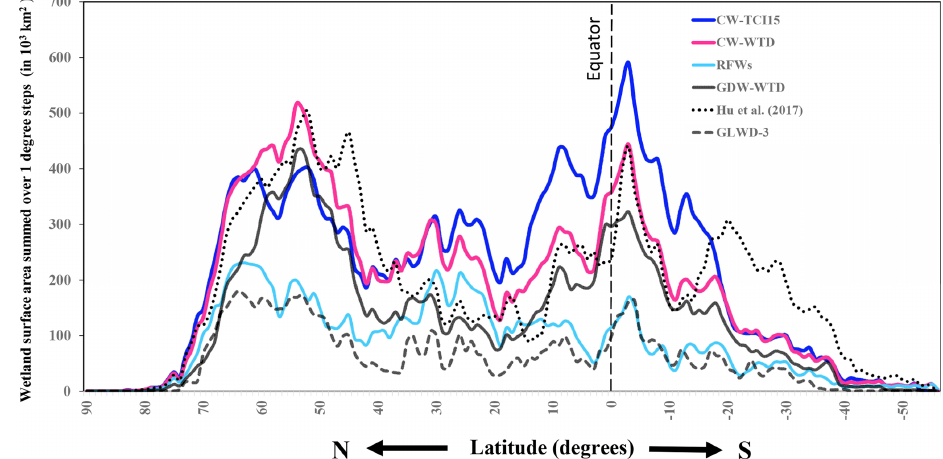
Figure 12. Latitudinal distribution of the selected CWs and evaluation datasets. The wetland areas along the y axis are surface areas in each 1 ◦ latitudinal